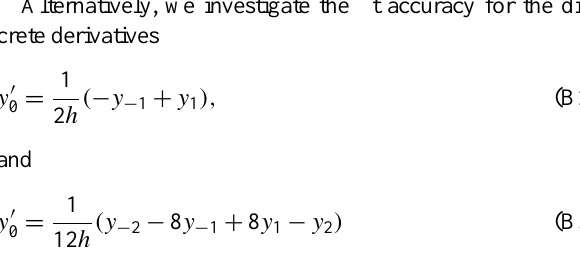
derivative and the fitted shift, respectively.